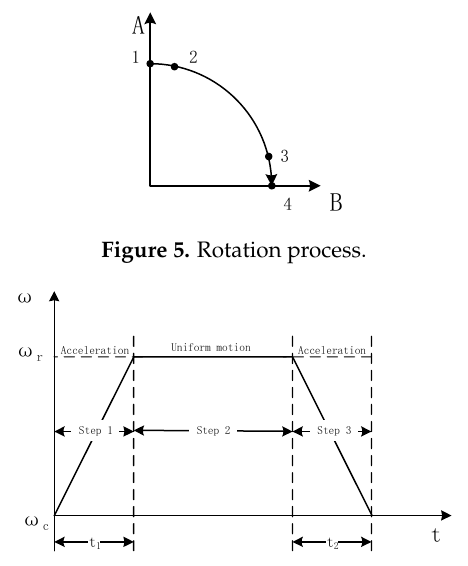
Figure 6. Diagram of the rotating angular velocity. Figure 5. Rotation process.